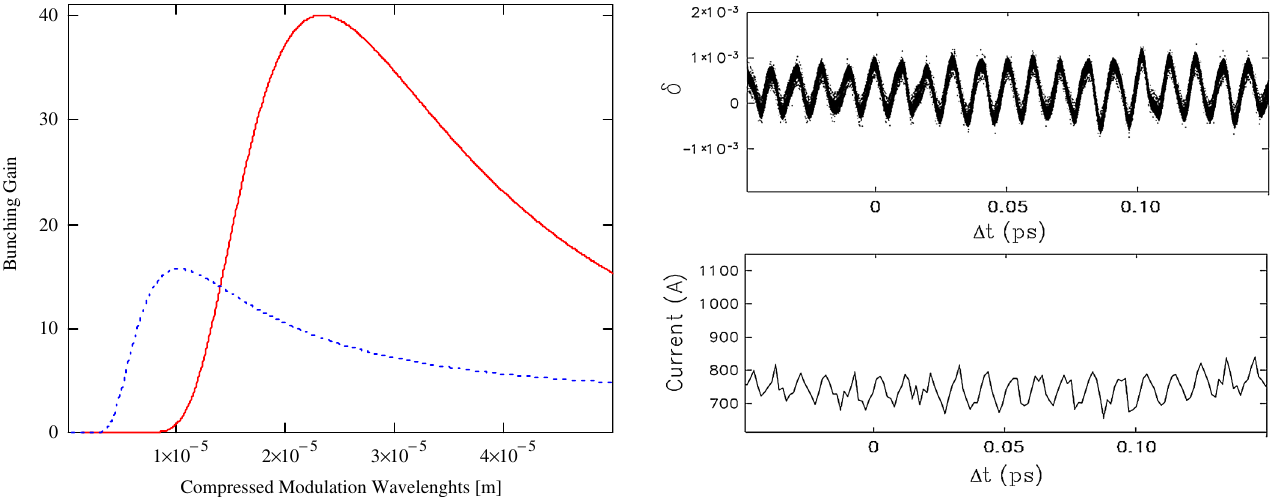
FIG. 6. (Color) Instability gain vs compressed modulation wave- length. The dotted line is for the single compression scheme. The solid line is for the linear energy chirp removed at BC2; this is made active only for additional rotation of the longitudinal phase space.